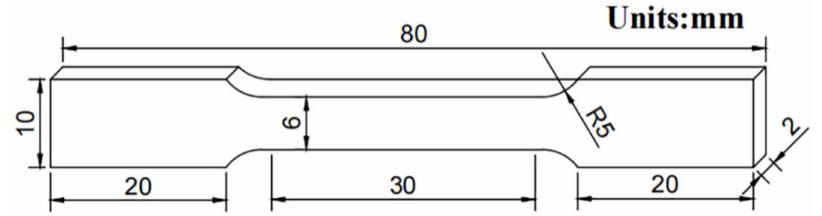
Figure 2. The dimensions of tensile specimens.